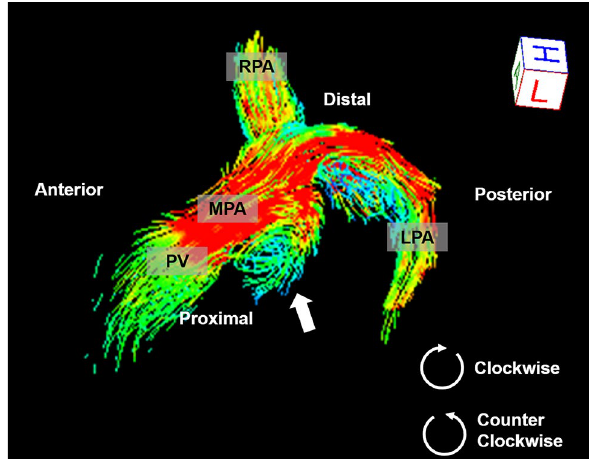
Figure 2. A 14-year-old boy with repaired Tetralogy of Fallot. Streamline imaging by 4D flow magnetic resonance imaging visualizes the pulmonary arteries. Clockwise vortices are seen at the posterior portion of the proximal main pulmonary artery when viewed from the patient’s left (arrow). Flow visualization was performed using 4D flow postprocessor software (iT Flow; Cardioflow Design. Inc., Tokyo, Japan). MPA main pulmonary artery, LPA left pulmonary artery, RPA right pulmonary